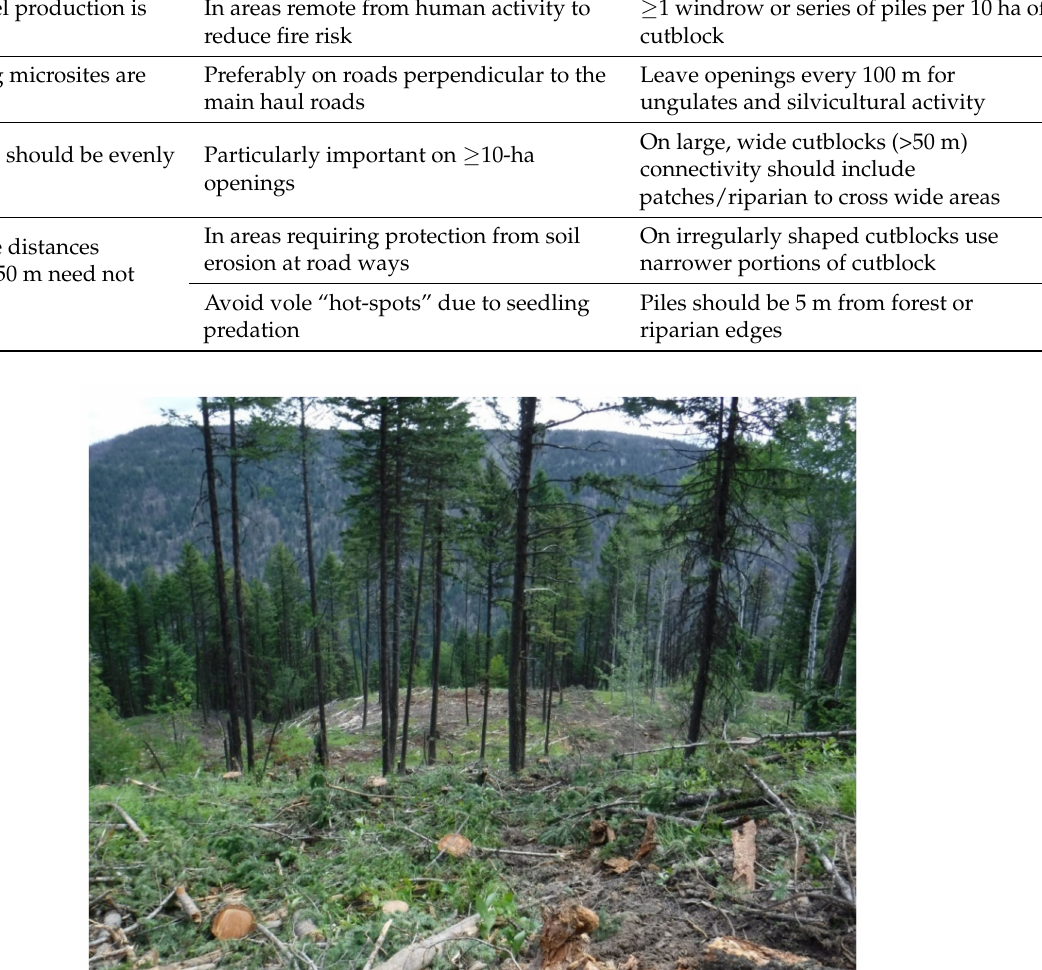
Table 2. What to do, when, and where during the creation of habitat structures and connectivity via debris piles. When During harvesting/log processing